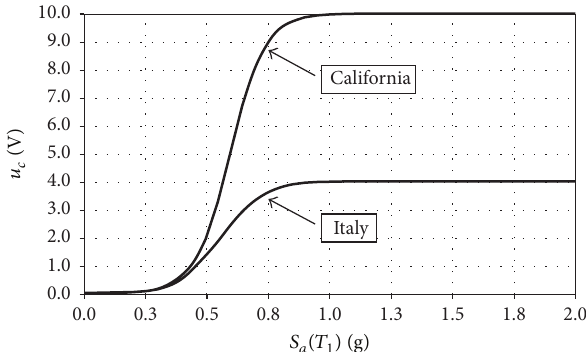
Figure 7: Regional control algorithms for Italy and California.